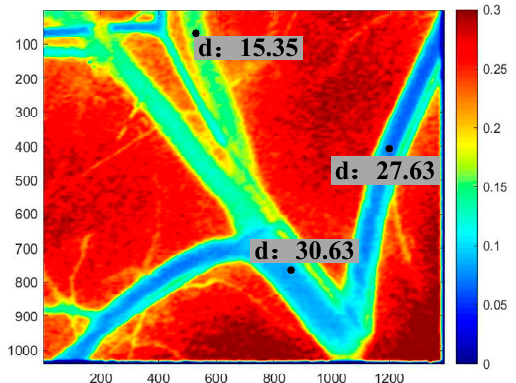
Figure 2. Diameter ( µ m) and velocity distribution (ms) obtained from speckle imaging.